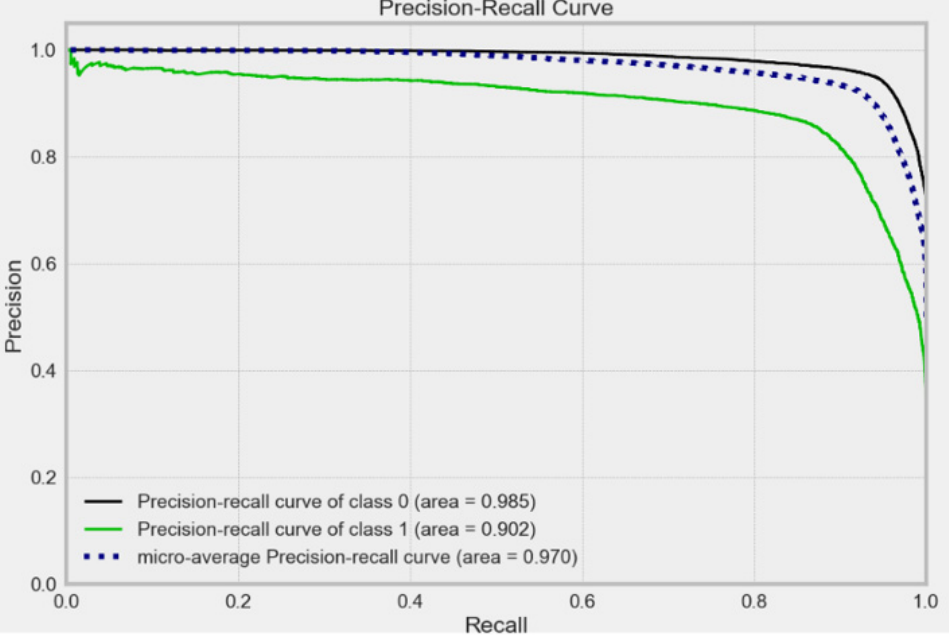
Figure 14. Precision–recall Curve for LightGBM model.